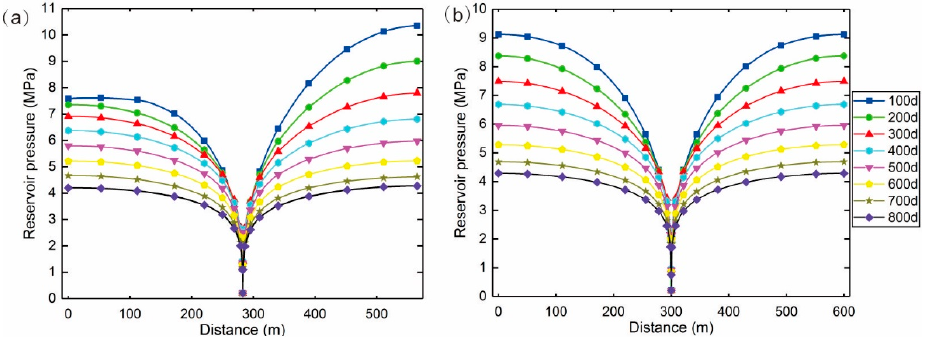
Figure 9. Distribution of the reservoir pressure, ( a ) along the reference line AB (the dip), ( b ) along the reference line CD (the strike).